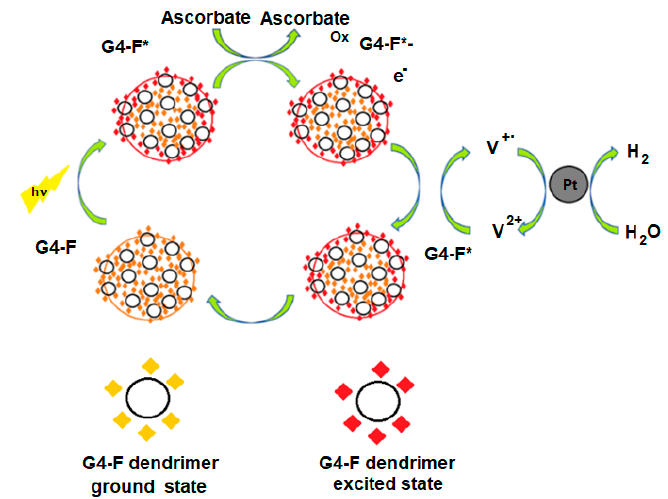
Scheme 1. Illustration of the possible mechanism for the process of water photoreduction using G4-F nanoaggregates as photosensitized systems.